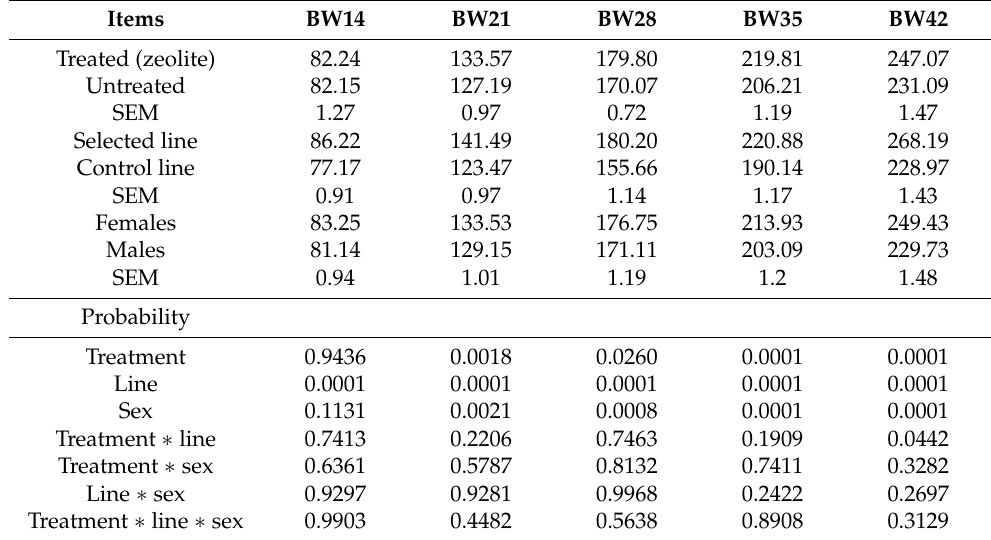
Table 2. Least square means for the body weight (BW, g) at different ages studied as affected